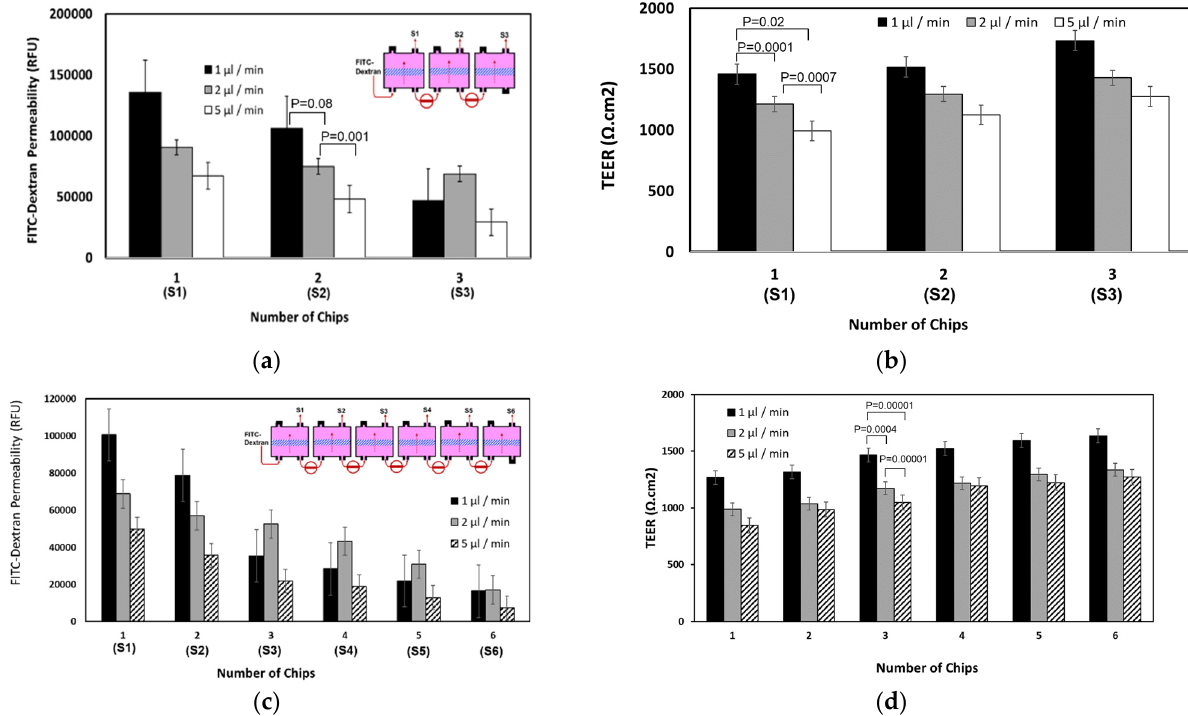
Figure 5. ( a ) The permeability of FITC-dextran through 3 chips linked to each other in a series through the lower (basolateral) compartments. The permeability was detected by measuring the intensity of FITC in the upper compartments. S indicates the sample collected from the corresponding upper compartment. ( b ) The corresponding TEER values. ( c ) The permeability of FITC-dextran through 6 chips. ( d ) The corresponding TEER values. Student t-test was used for statistical analysis. p < 0.05 was considered significant.